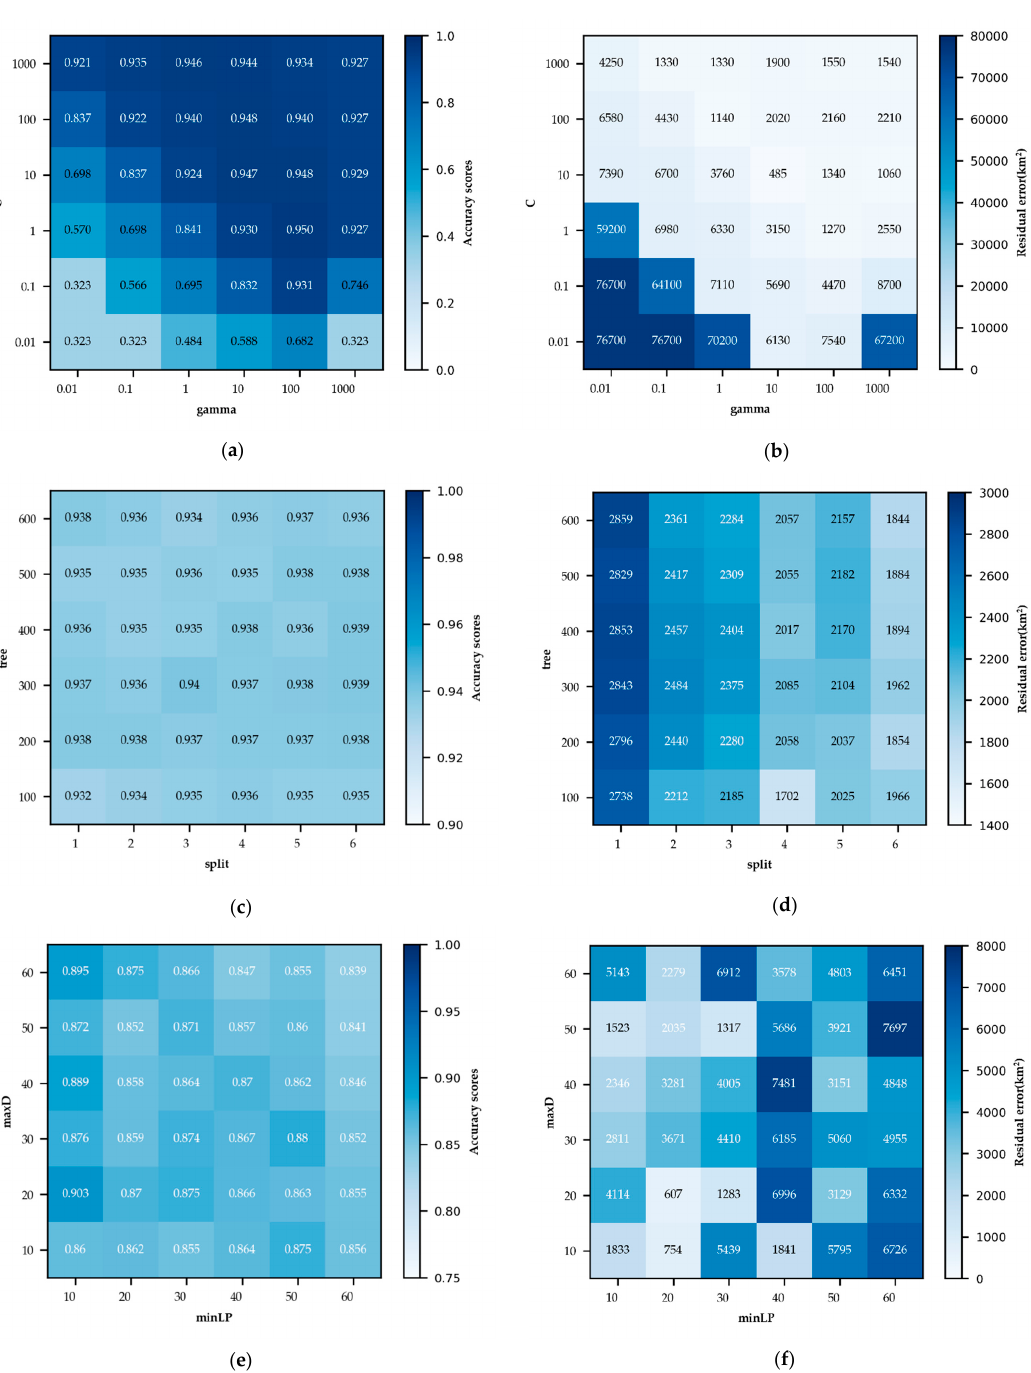
Figure 7. The accuracy scores and residual errors of SVM, RF, and CART with different algorithm parameters . ( a , c , e ) The accuracy score chart; ( b , d , f ) the residual error chart. By analyzing the sensitivity of SVM toward (C and gamma) (Figure 7a,b), it can be seen that as the values of (C and gamma) gradually increase, the accuracy score increases, and the residuals decrease. When the values of (C and gamma) are less than (1 and 1), the accuracy scores are small. In particular, when the (C and gamma) values are (0.01 and 0.01), (0.01 and 0.1), (0.01 and 1000), and (0.1 and 0.01), the accuracy scores all are 0.323, which are the smallest scores. In Figure 7b, as the (C and gamma) increase gradually, the residual values decrease accordingly. When the values of (C and gamma) are (0.01 and 0.01), (0.01 and 0.1), (0.01 and 1000), and (0.1 and 0.01), the maximum residuals are 76,700 km 2 . When the values of (C and gamma) are (1000 and 1000), the residuals are 1540 km 2 . When parameter C is small, the penalty for error is relatively large [19,48], which results in the phenomenon of underfitting, leading to large classification residuals. With the increase in gamma values, although the decision boundary becomes smoother and individual features can be better fitted, overfitting may also occur [48]. When (C and gamma) are (1 and 100), the accuracy score is 0.95. In general, when the values of (C and gamma) are small, the error penalty for the classified data is larger, and the accuracy scores are generally smaller. As the values of (C and gamma) increase, so does the accuracy score. When the values of (C and gamma) exceed (1 and 1),